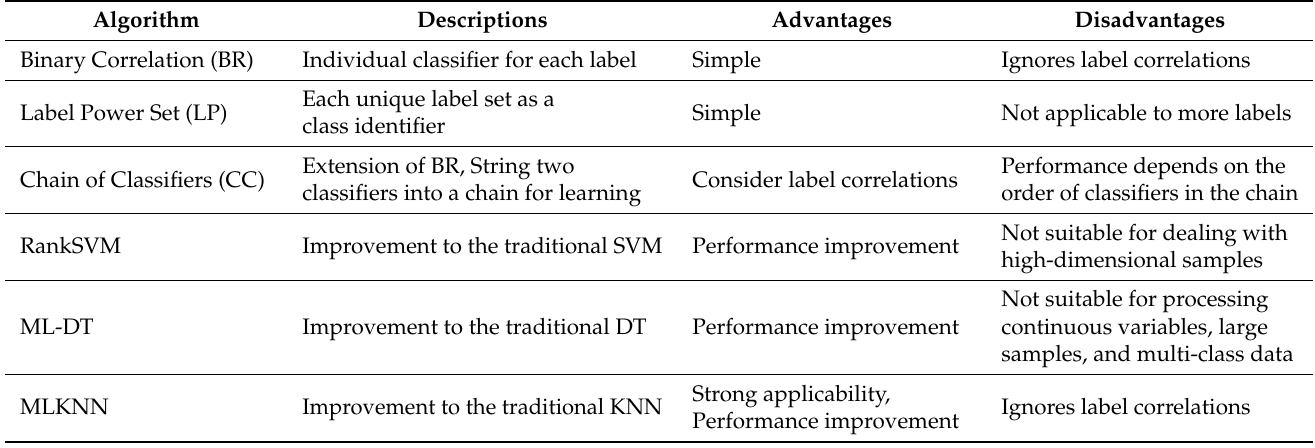
Table 1. Summary of advantages and disadvantages of multi-label learning